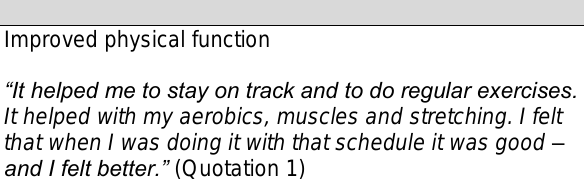
Table 4. Main Highlights and Sample Quotations